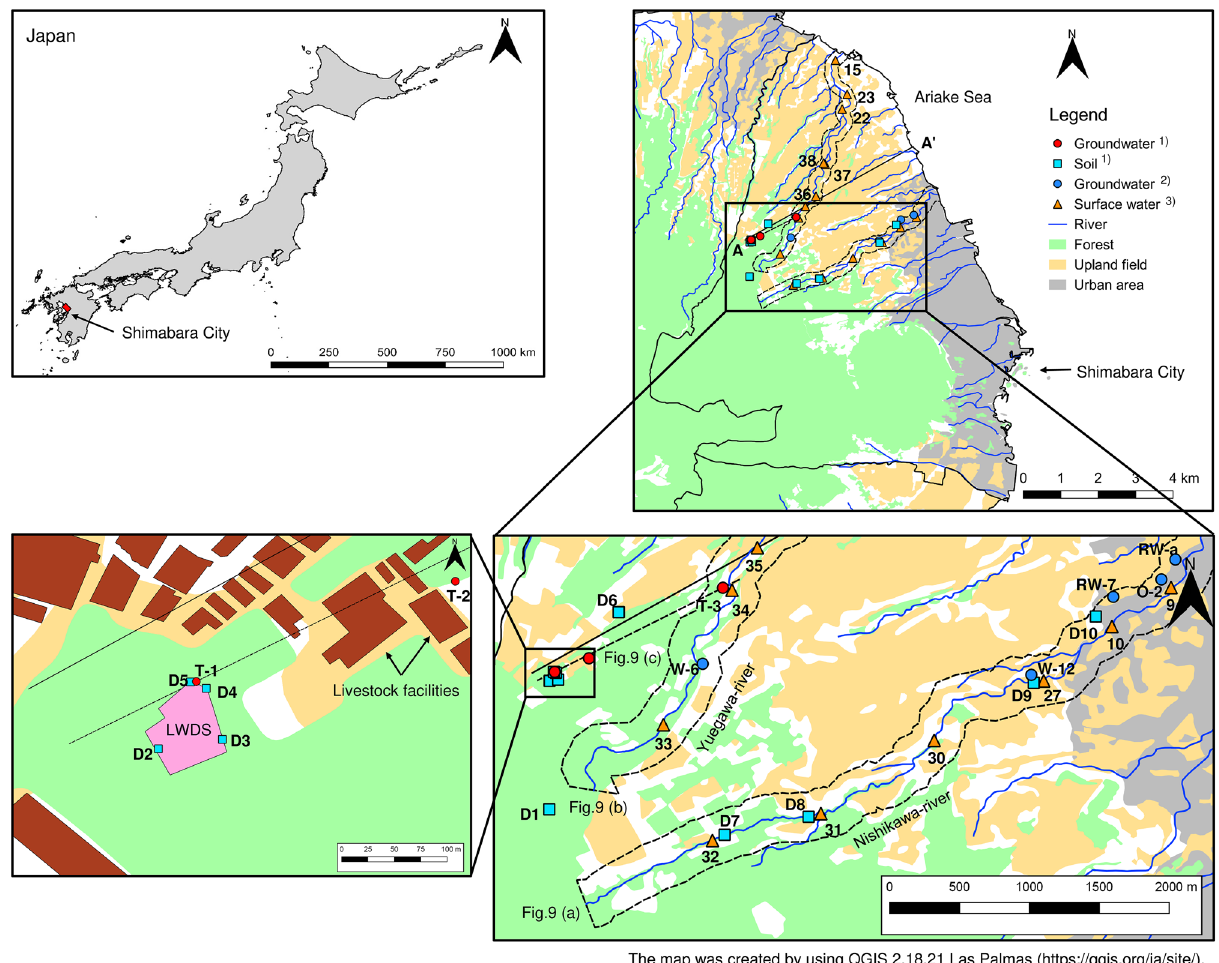
Figure 1. Study area. (1) this study. (2) Nakagawa et al. 17 , (3) Amano et al. 19